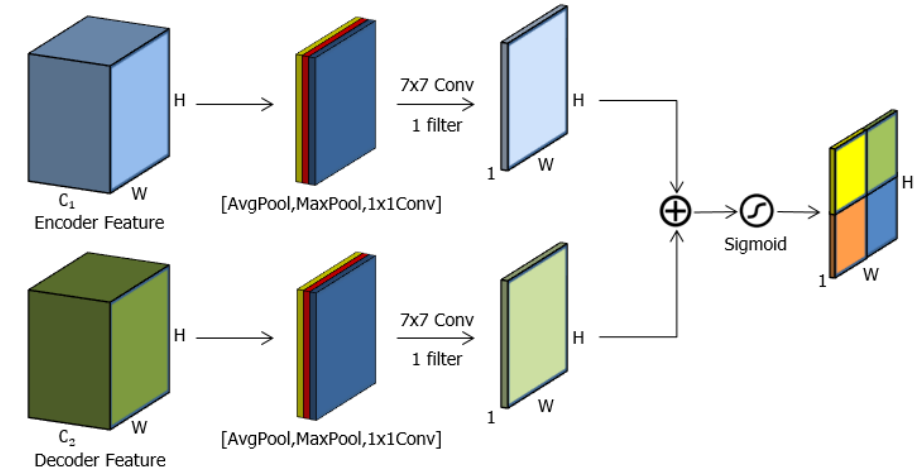
Figure 2. Diagram of the Spatial Attention Gate (sAG).